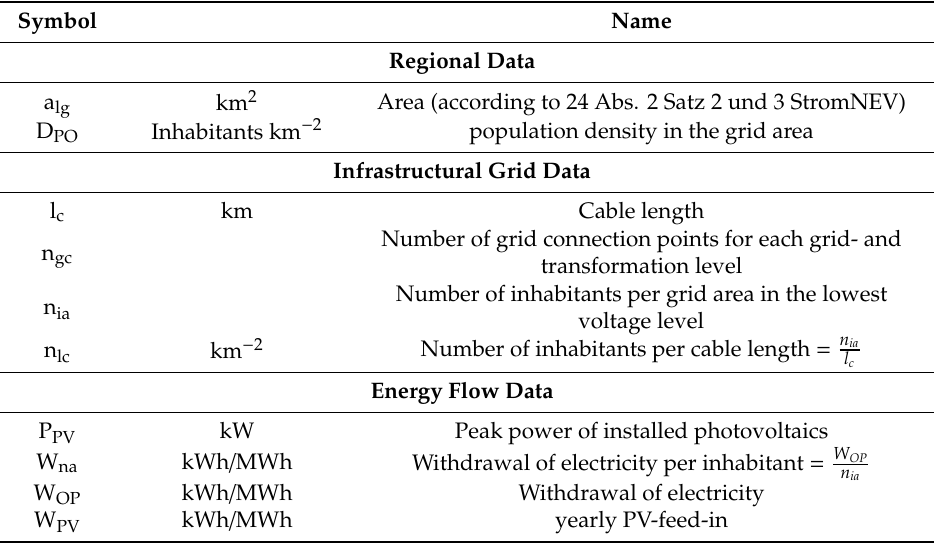
Table 3. Data in